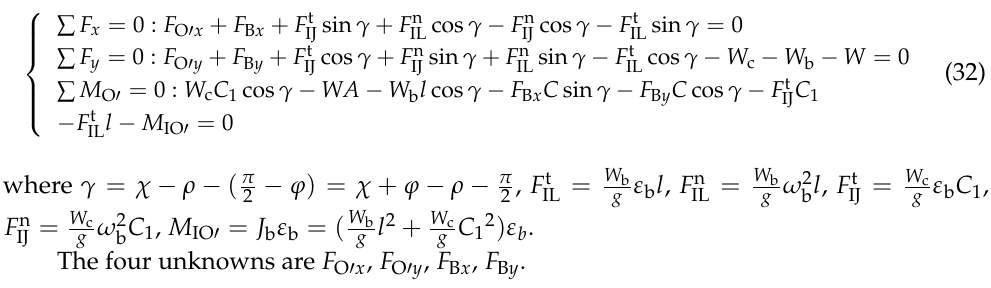
Figure 8. Force analysis of the beam.